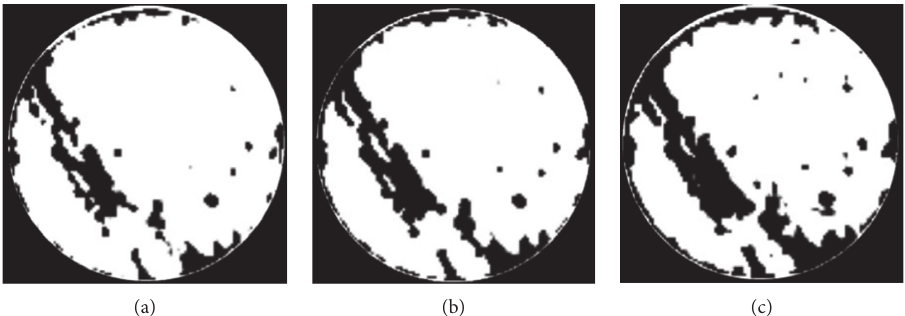
Figure 13: Prediction maps of damage propagation in fine red sandstone M1. (a) 140 cycles. (b) 180 cycles. (c) 200 cycles.